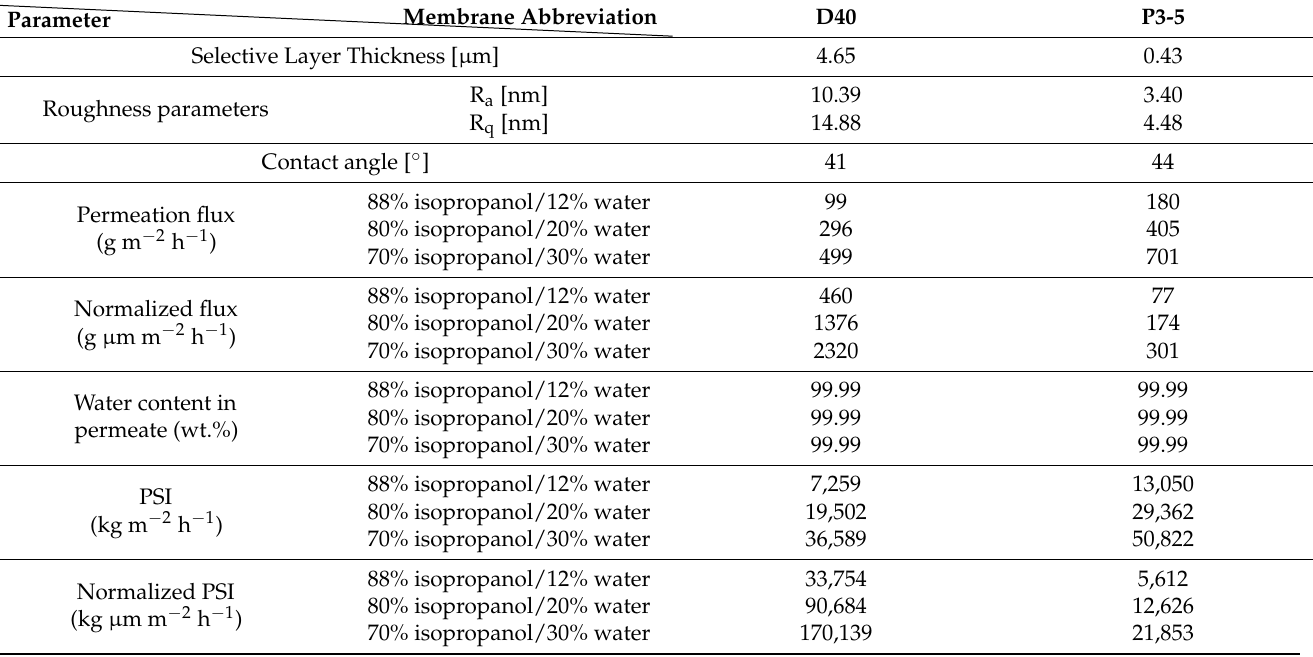
Table 6. Comparison of D40 and P3-5 TFN membrane